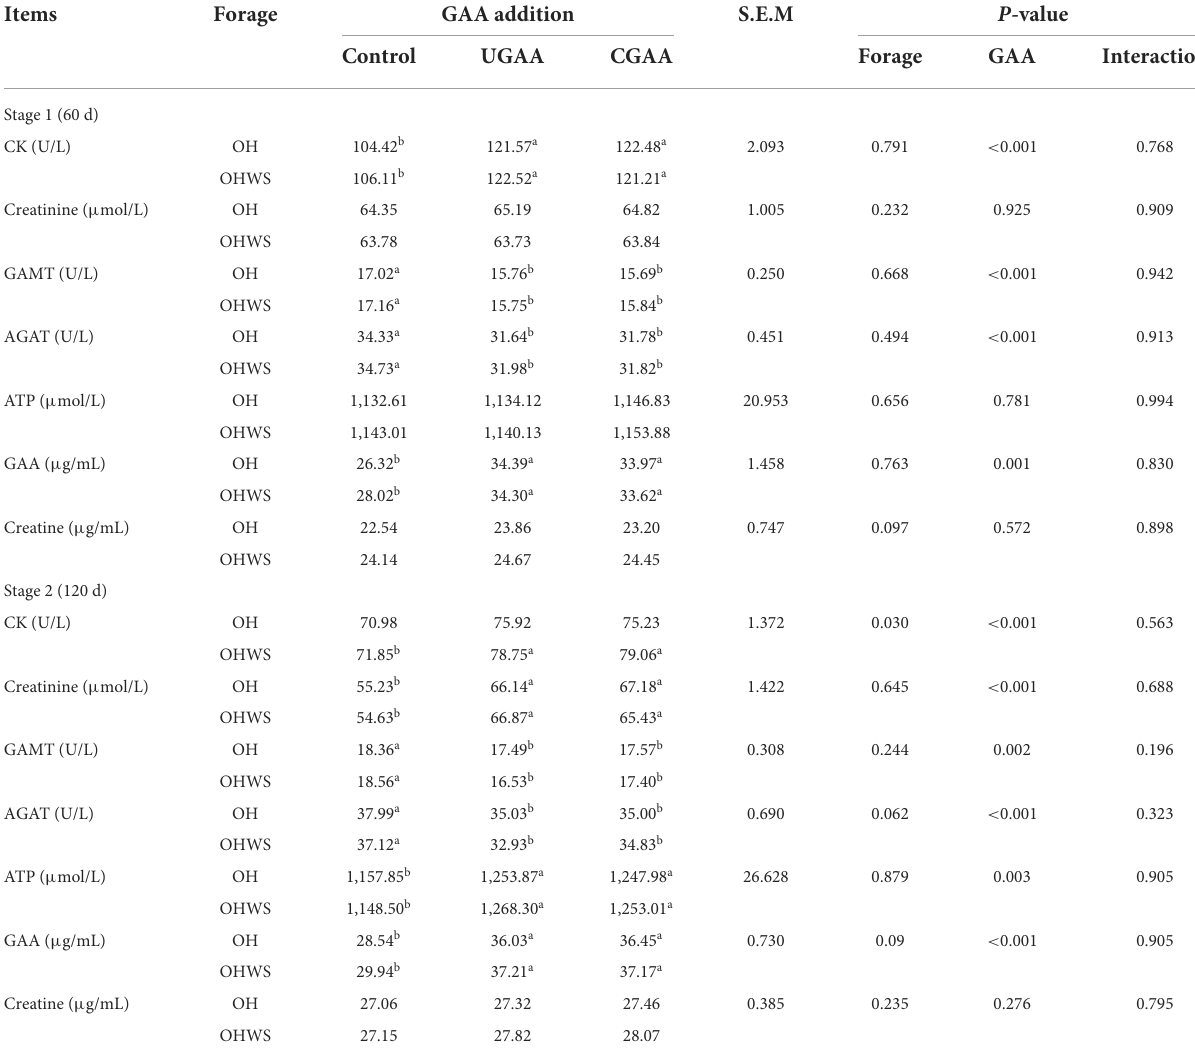
TABLE 6 Effects of forage type and guanidine acetic acid (GAA) addition on GAA, creatine, and creatine-related metabolites in feedlotting lambs at different feeding stages (stage 1, 60 day; stage 2, 120